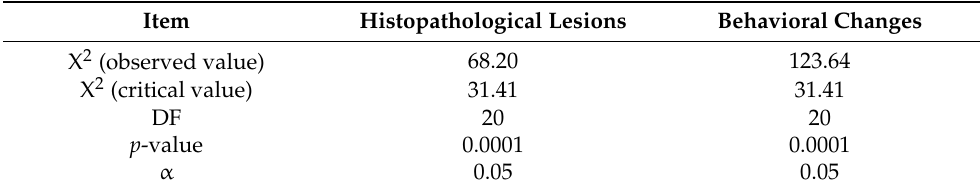
Table 4. Results of X 2 analysis of histopathological lesions and behavioral changes observed in rainbow trout fingerlings infected with several Aeromonas species.